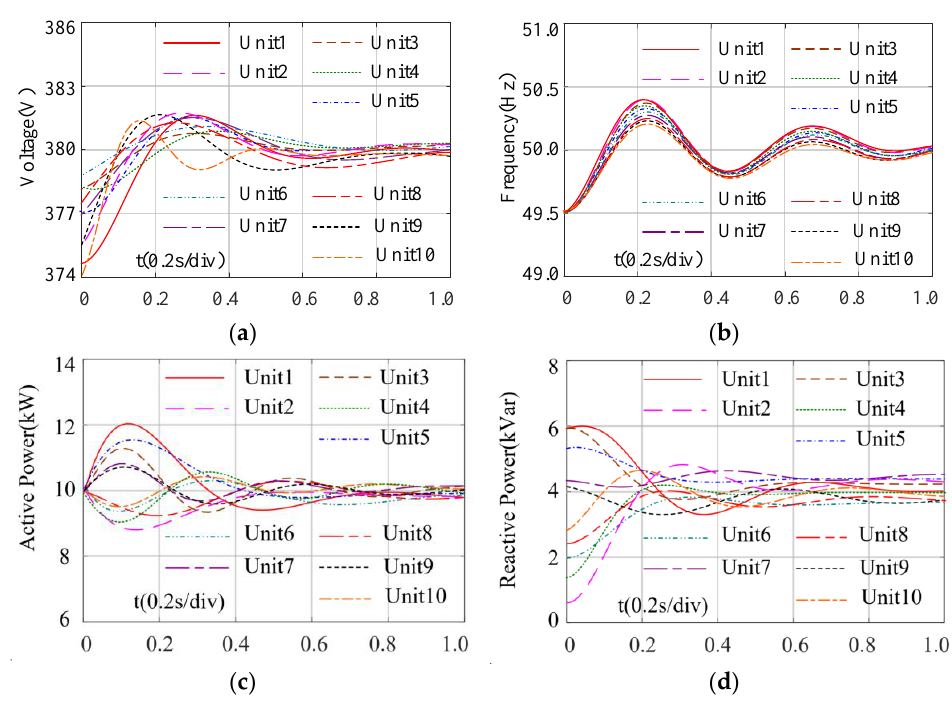
Figure 7. The simulation results with the control strategy in [25]. ( a ) voltage amplitude;( b ) frequency;( c ) active power;( d ) reactive power.